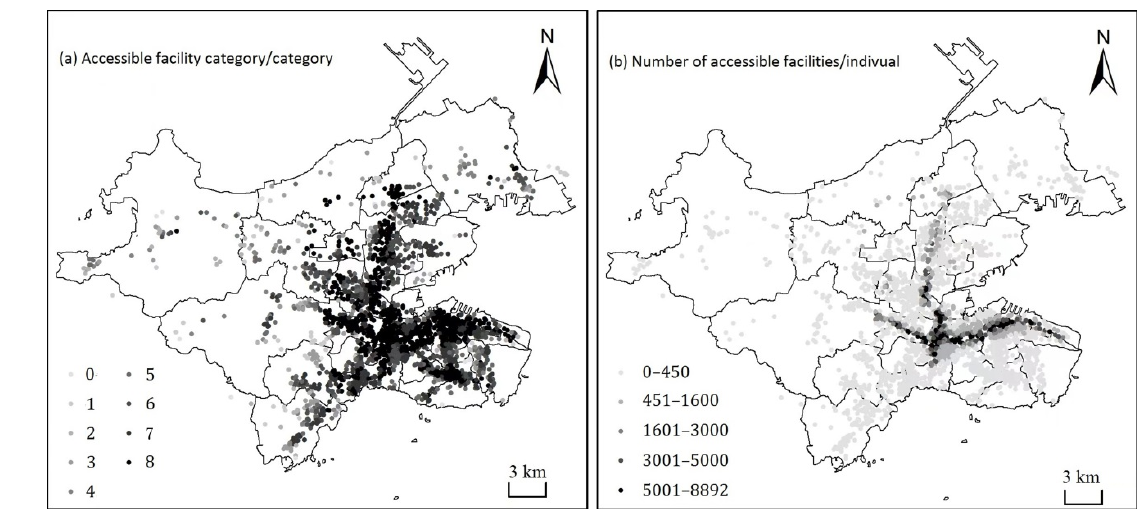
Figure 3. Accessible facilities for inhabitants of each residential area.